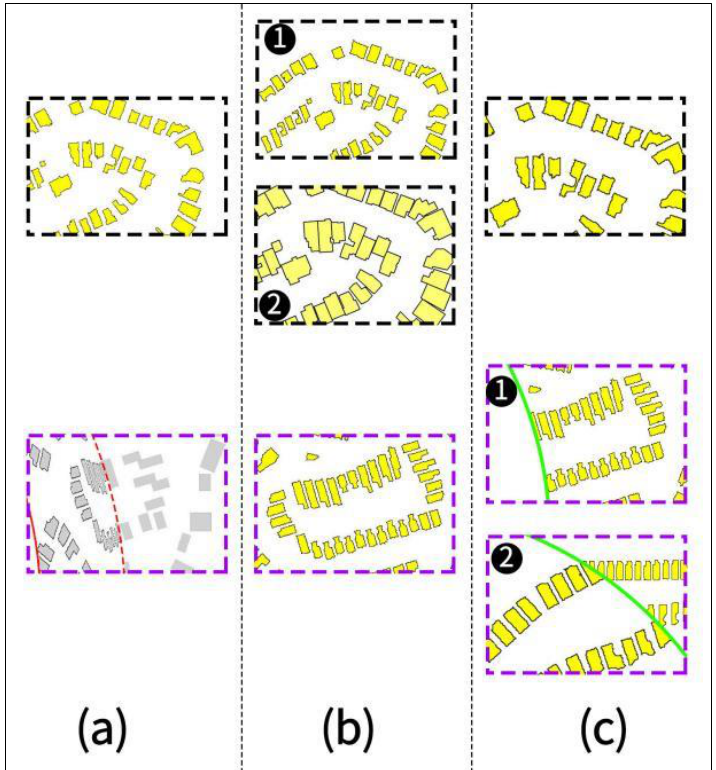
Figure 19. Comparison of details of different variable-scale methods in different regions. ( a ) Comparison area in the variable-scale map. ( b ) Comparison area in the eagle eye map. ( c ) Compare area in the roaming area in the roaming map.